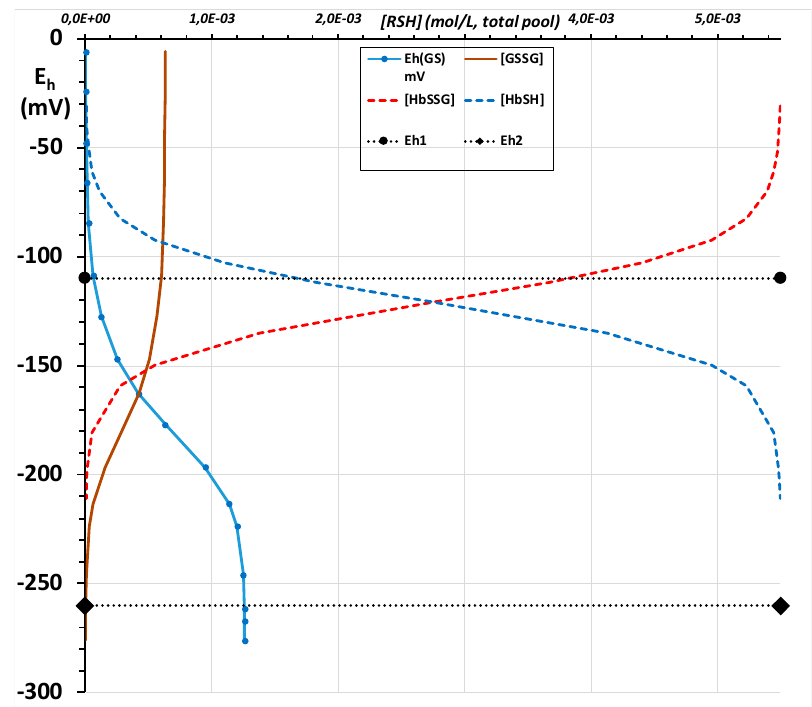
Redox curves of glutathione and hemoglobin in the RBC, plotted as the E h of the half-cell (vertical) as a function of the concentration of each oxidized and reduced thiol.